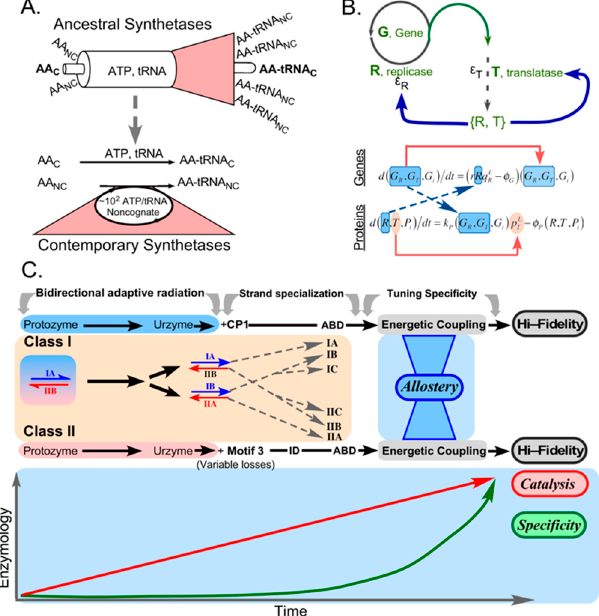
Figure 6. Challenges facing the evolution of aaRS associated with expanding the coding alphabet by introducing new aaRS tRNA cognate pairs. ( A ). High precision cannot be achieved using a single association dissociation equilibrium because some amino acids have similar side chains and bind to non-cognate aaRS with dissociation constants nearly 1% of those for cognate amino acids. Nature had to couple multiple binding events without allowing dissociation to enable contemporary aaRS to surpass this thermodynamic limitation. As a consequence, dissipation of information in mRNA codescripts due to translational errors by ancestral aaRS (horizontal red fan) was converted into dissipation of chemical free energy in contemporary aaRS (vertical red fan). ( B ). Coupling of replication to translation illustrated by the Gene-Replicase-Translatase model system. Rudiments of the GRT system are the replicase and translatase catalysts and their genes (green). Processes necessary to generate the active catalysts, R and T, are replication (circle), translation (dashed line), and folding (blue lines). No distinction is made between duplication and transcription of the respective genes, G, in a world where genetic information is instantiated in RNA. Errors are denoted by ε . Differential equations for the two processes [12] are coupled in both directions via the population variables (dashed arrows) and exhibit autocatalysis (red arrows). (Parts A and B were adapted from [18].) ( C ). Evolutionary events in aaRS evolution. (Top) The schematic illustrates three distinct stages in the structural and genetic development of aaRS. (Bottom) Experimental data [98] have shown that the catalytic proficiency of both classes is a linear function of the number of amino acids, and by implication with time. Specificity, however, likely failed to develop until the allosteric mechanisms could accomplish fine